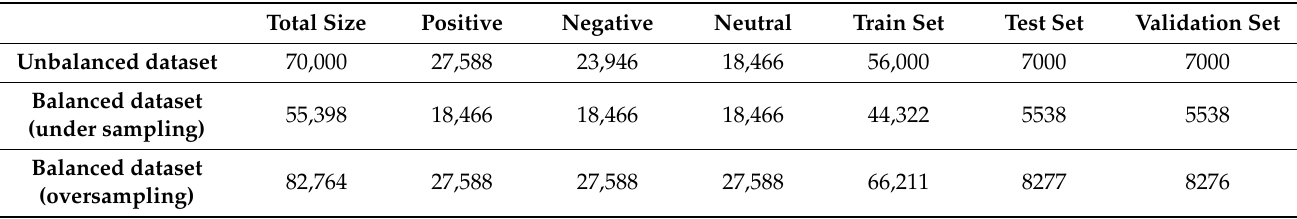
Table 5. Summary of the balanced and unbalanced